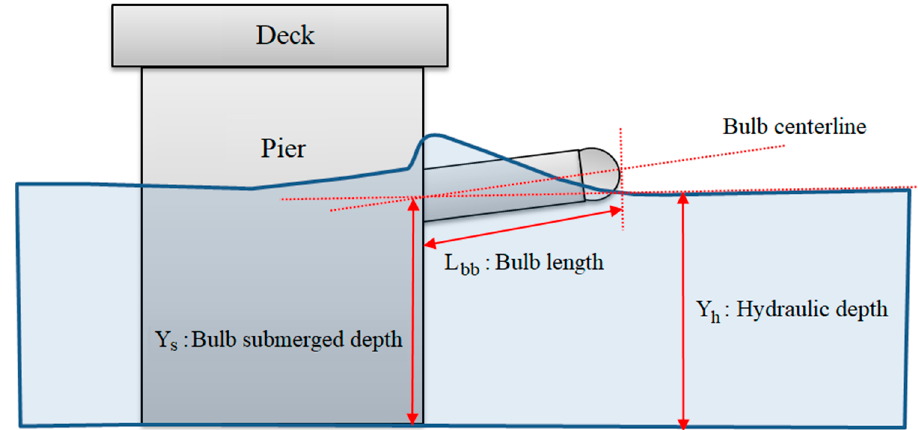
Figure 30. Definition of the bulb submerged depth and bulbous Figure 28. Definition of the bulb submerged depth and bulbous length.